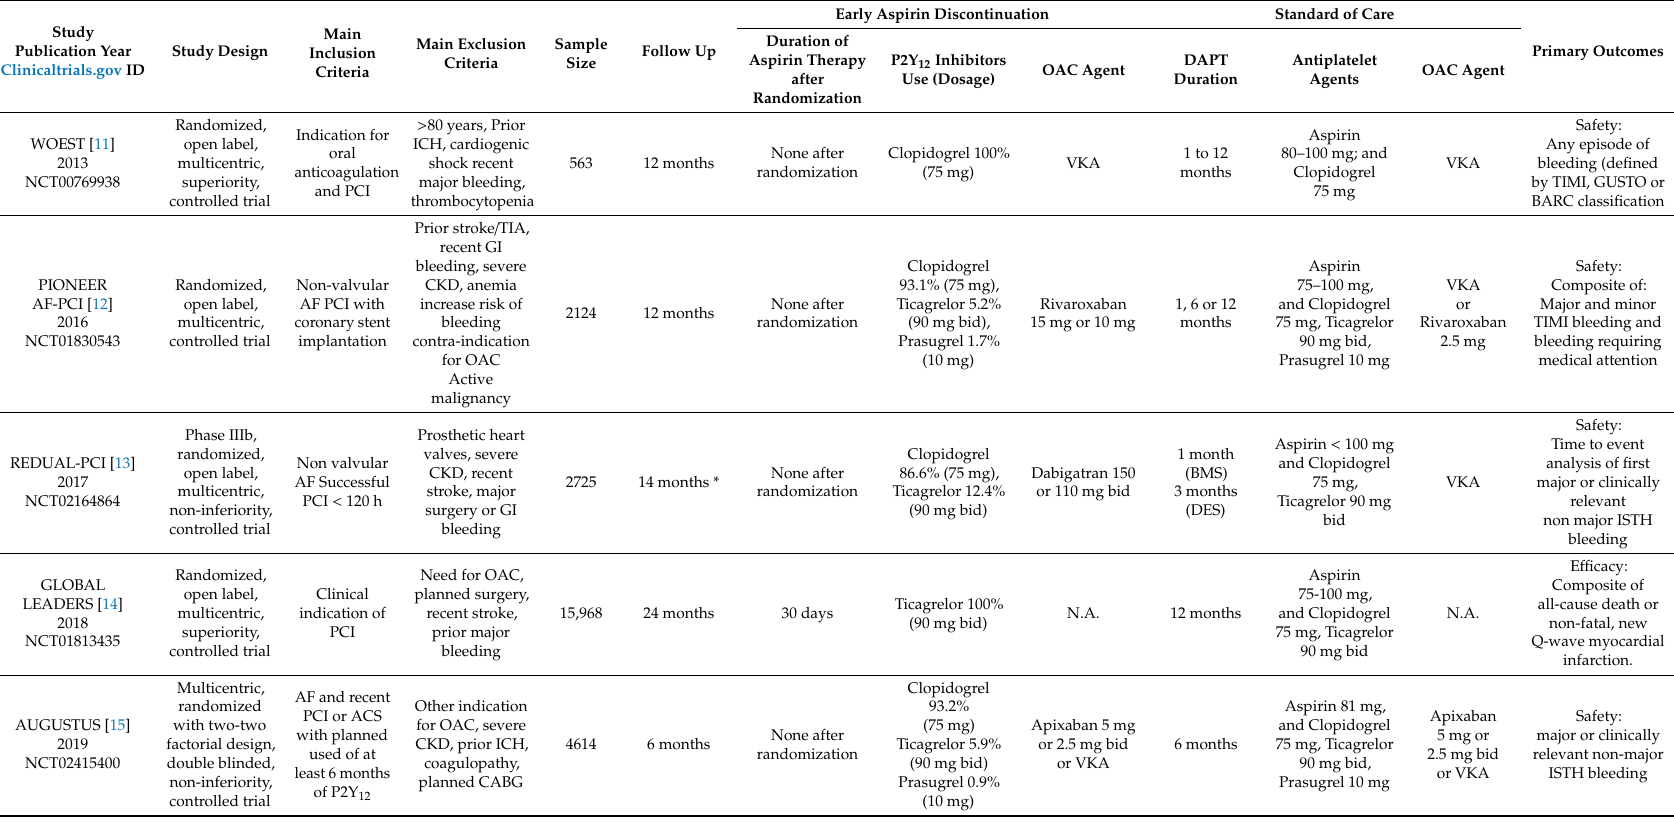
Table 1. Characteristics of the included